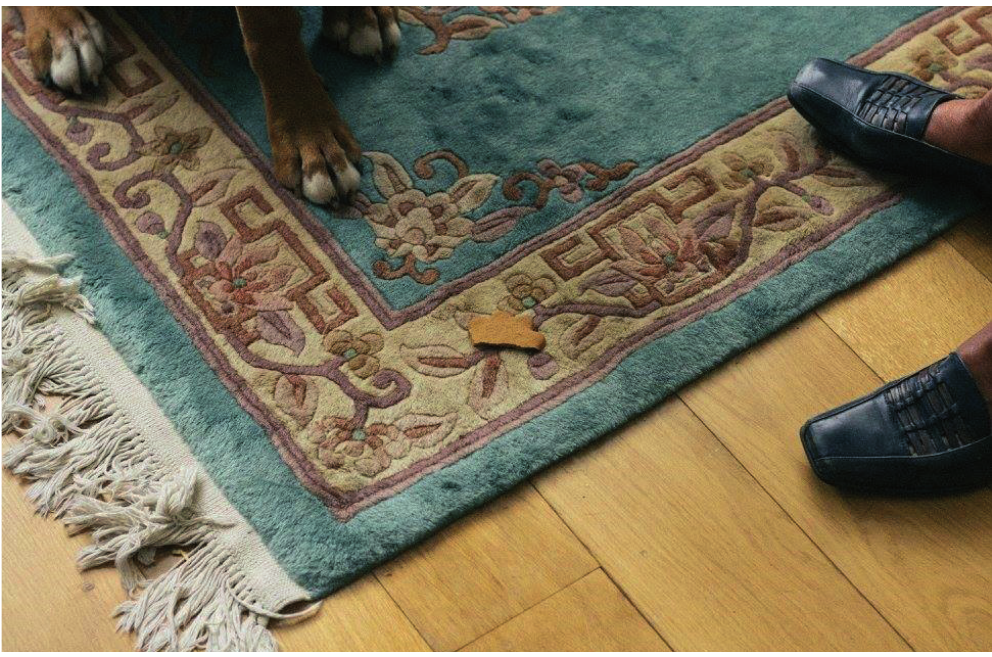
Figure 9: Breaking the biscuit: A Swedish custom; from the series ‘A Great Wish’